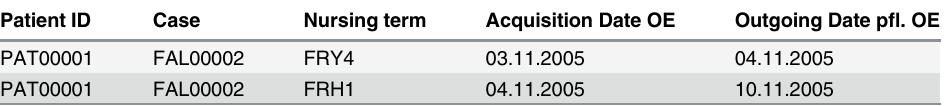
Table 1. Example entries for a case of a patient with the ID